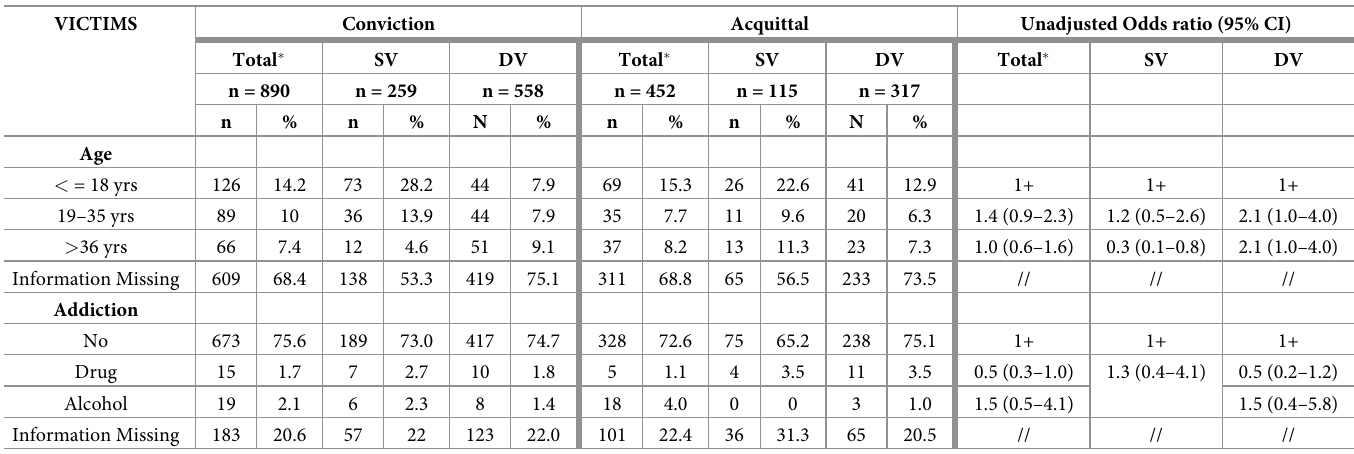
Table 2. Distribution of victims according to age and addiction. VICTIMS